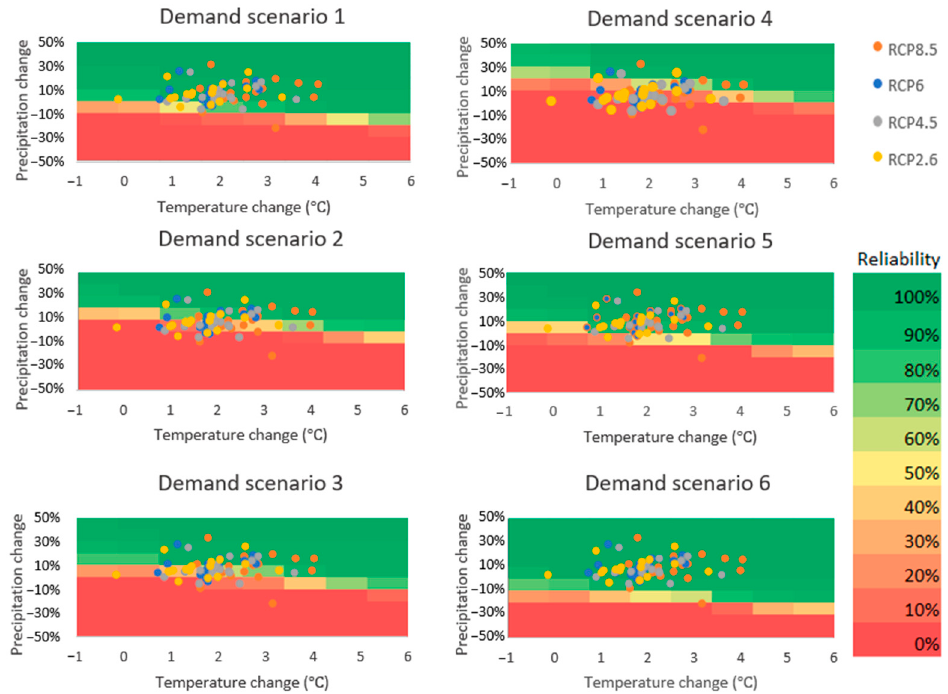
Figure 8. GCM projections for RCP2.6, RCP4.5, RCP6 and RCP8.5 and reliability of environmental flows to the Ili delta under six different upstream water demand scenarios.